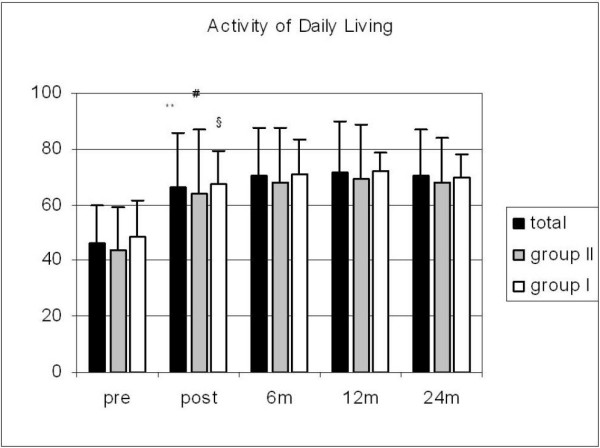
Activity of Daily Living scores in all patients as well as in groups I and II preoperatively (with/without medication) and at the different postoperative follow-up times; significant differences between pre- and postoperative scores in all groups (**, #, § p < 0.05).